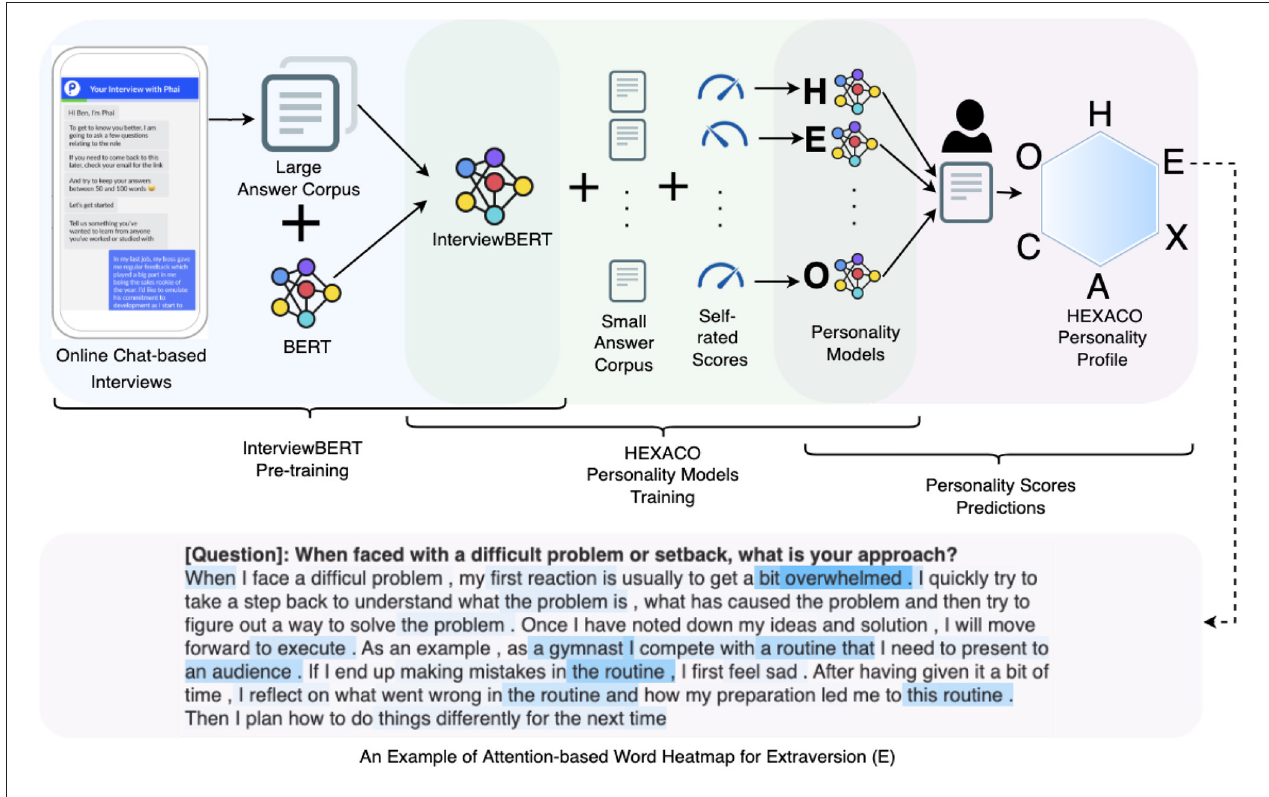
FIGURE 1 | Illustration of InterviewBERT based HEXACO personality